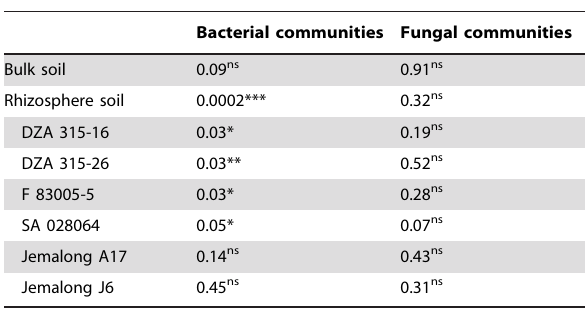
Table 1. Statistical analysis results of the effect of N treatment on both bacterial and fungal communities in the bulk soil and in the rhizosphere soil of different Medicago truncatula